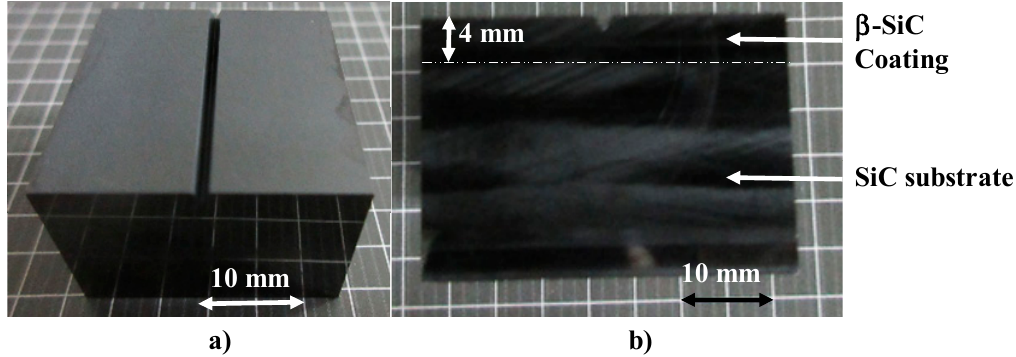
Figure 2. SiC-coated SiC die with a triangular cavity on its surface. ( a ) Perspective view and ( b ) side view.